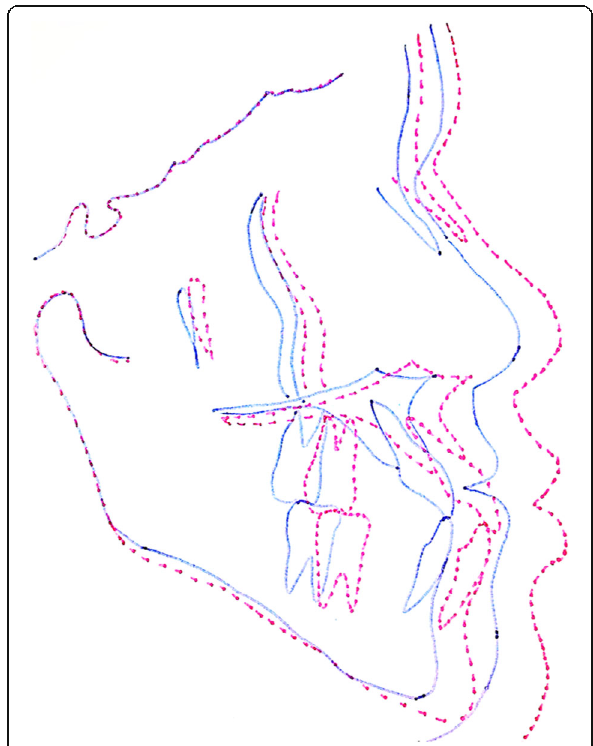
Fig. 4 Cephalometric superimposition of a patient of group